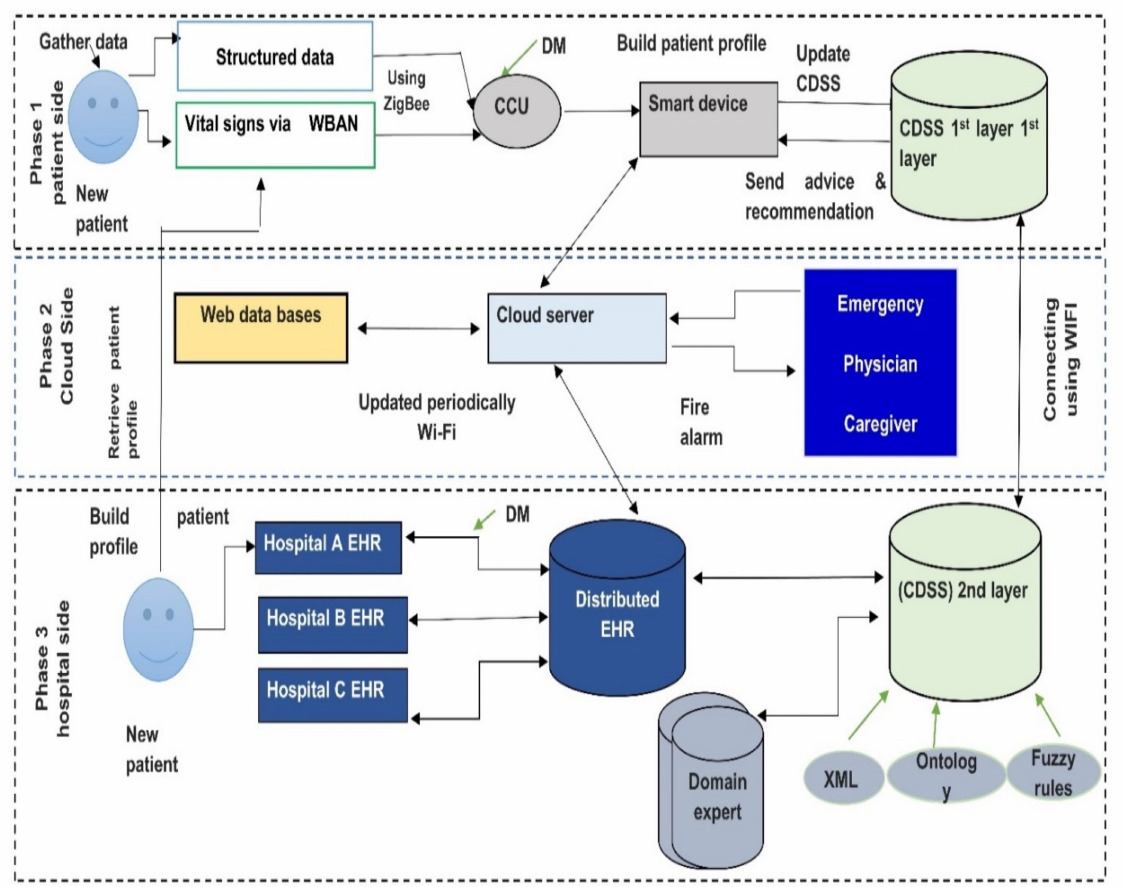
Figure 5. Case study for monitoring system for chronic disease